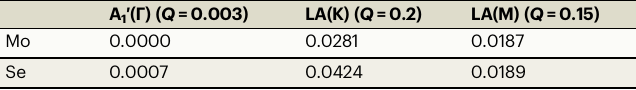
Table 2 | Maximum displacements of Mo and Se atoms in monolayer MoSe 2 deformed by the A 1 ′ ( Γ ), LA(K), and LA(M)